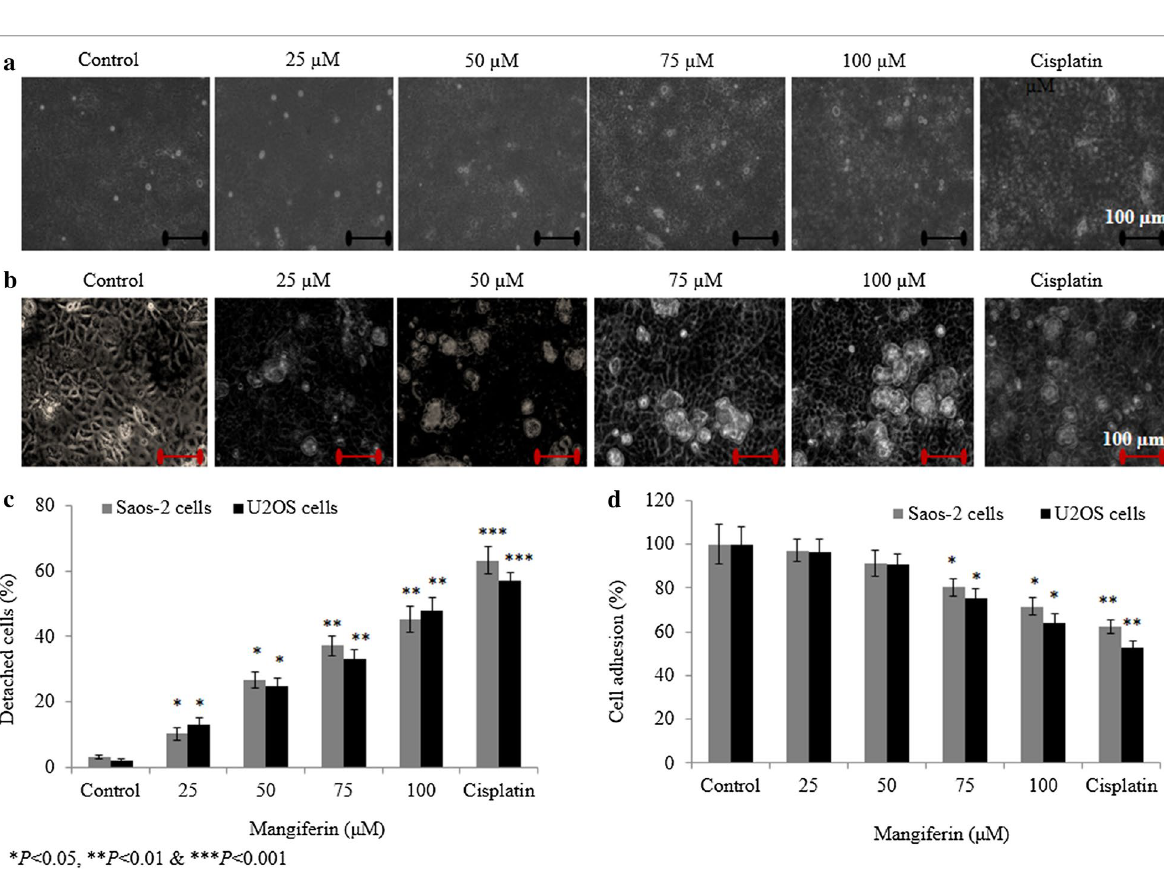
Fig. 4 Effect of mangiferin on the osteosarcoma cell detachment and cell adhesion. Cells were incubated with mangiferin (25–100 µM) for 72 h. a Represents the detachment level of Saos-2 cells, b Represents the detachment level of U2OS cells and c percentage analysis of a and b. D: Represents the cell adhesion rate. N 6. Control vs. * P < =